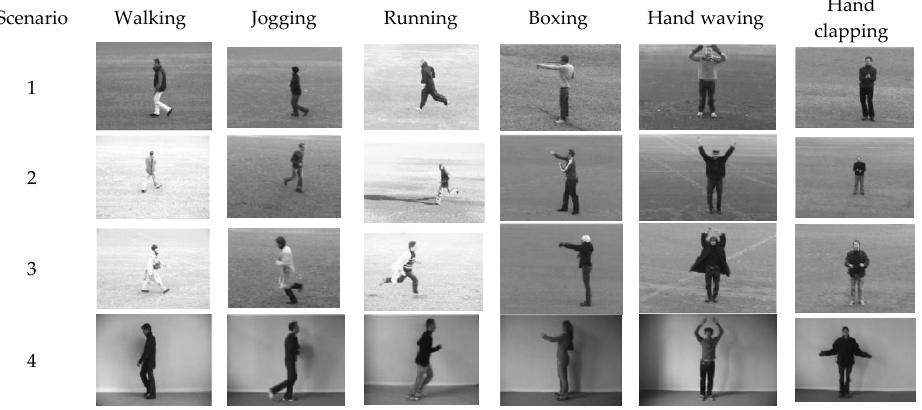
Figure 12. One frame example of each action from four different scenarios in the KTH dataset.